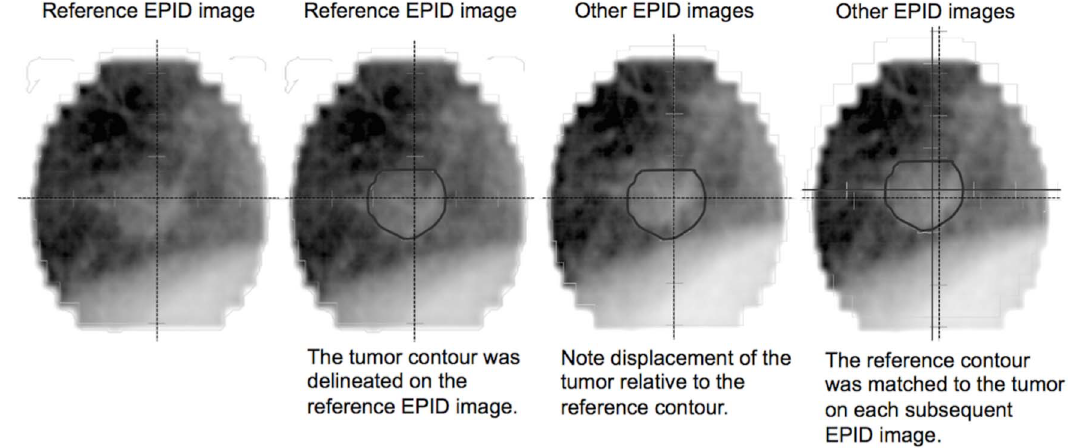
Figure 1. Tumor displacement measured with reference to the first EPID image acquired at the first session. EPID = electronic portal imaging device.